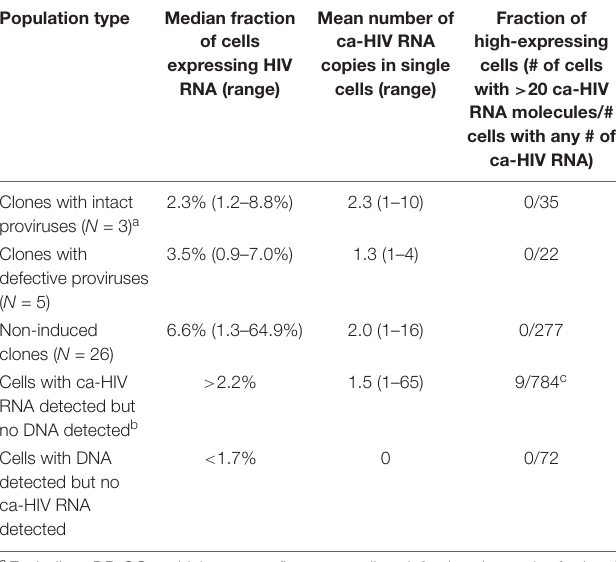
TABLE 1 | Fraction of proviruses expressing ca-HIV RNA and levels of expression in single